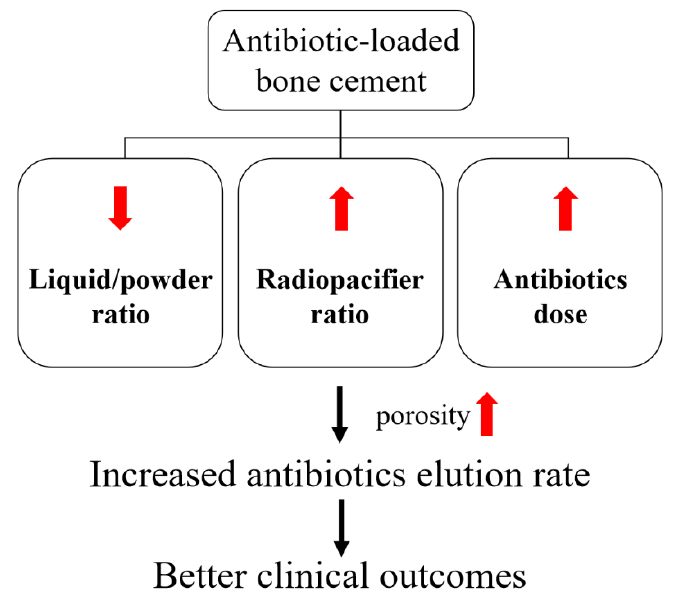
Figure 8. Decreased liquid/powder ratios, increased radiopacifier ratios and higher antibiotic doses may improve the elution rate of antibiotics from ALBC and therefore enhance the clinical efficacy against infection.